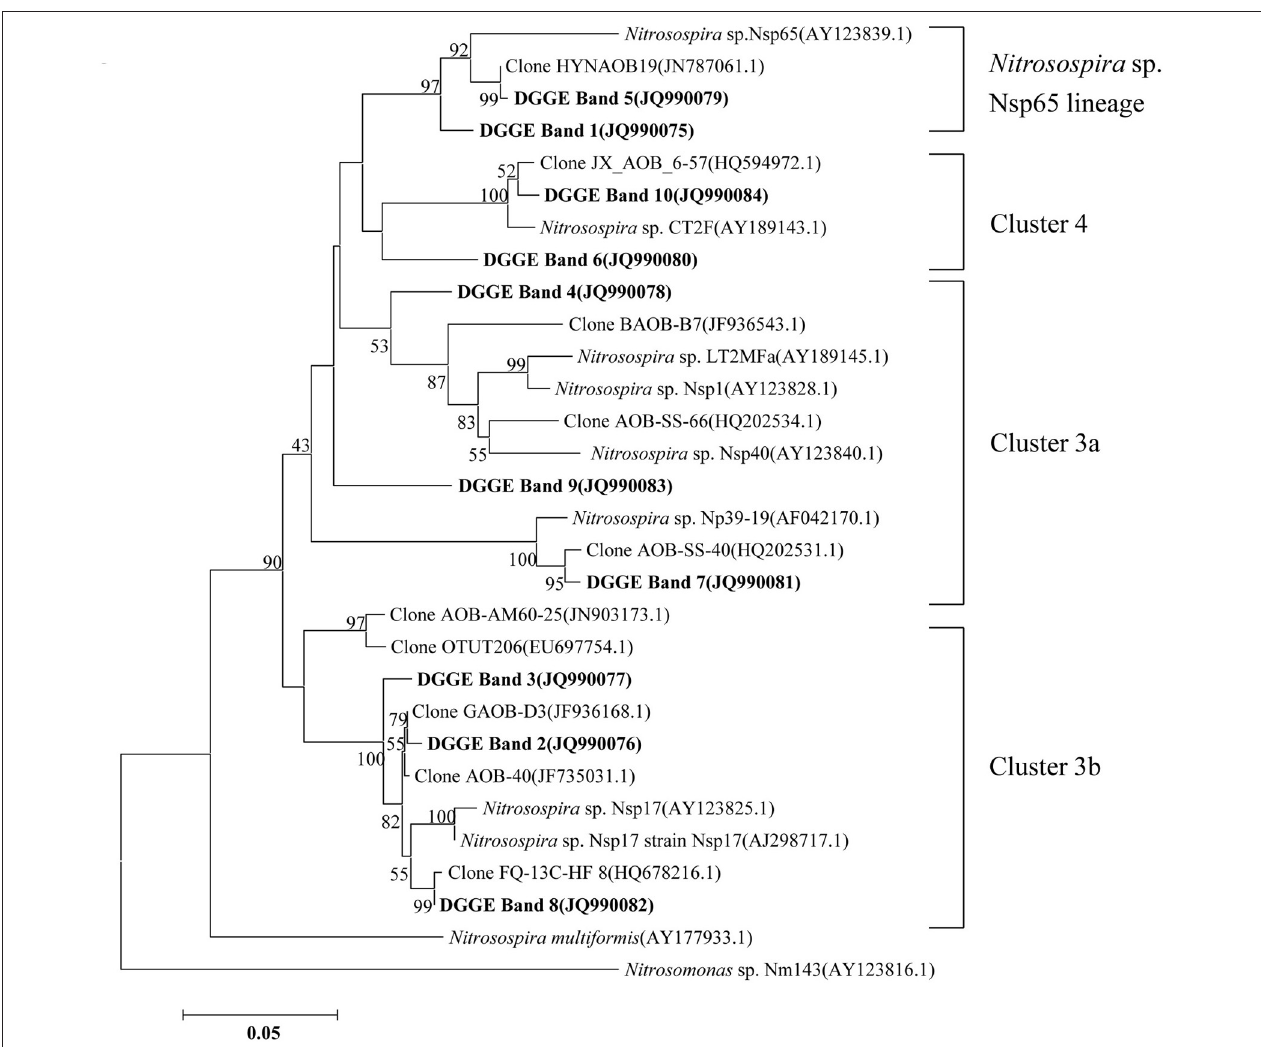
FIGURE 7 | Neighbor-joining tree showing the relationships of the bacterial amoA genes retrieved from the DGGE bands (bold) in this study to those in the GenBank. The scale bar indicates 5 changes per 100 nucleotide acid positions. Bootstrap values ( > 40%) are indicated at branch